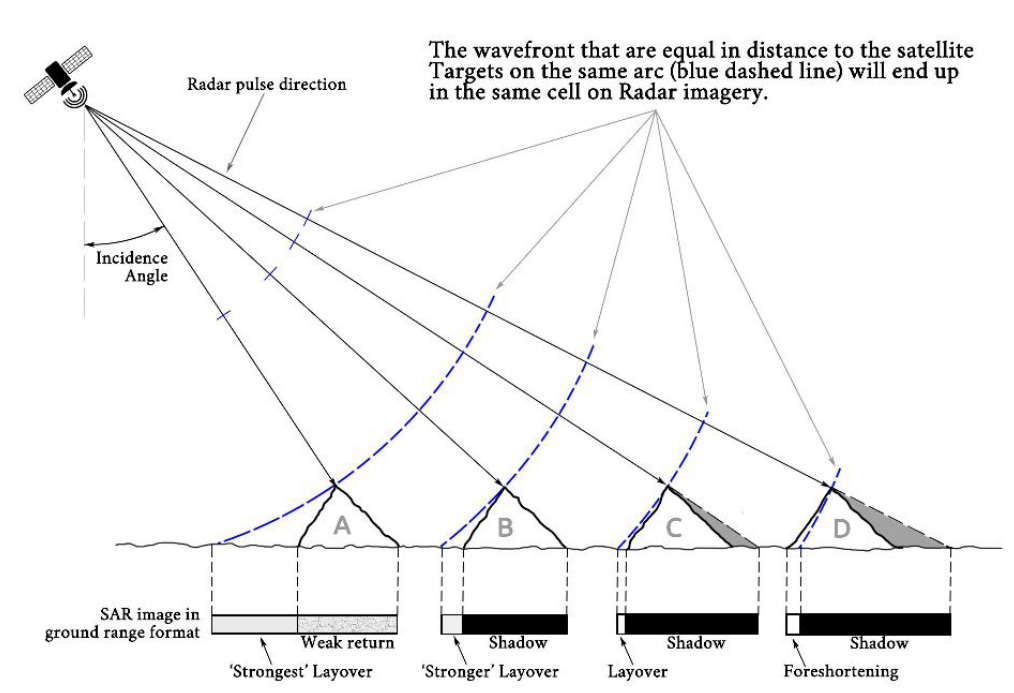
Figure 3. Geometric distortion on synthetic aperture radar (SAR) imagery as the effect of terrain. Courtesy of